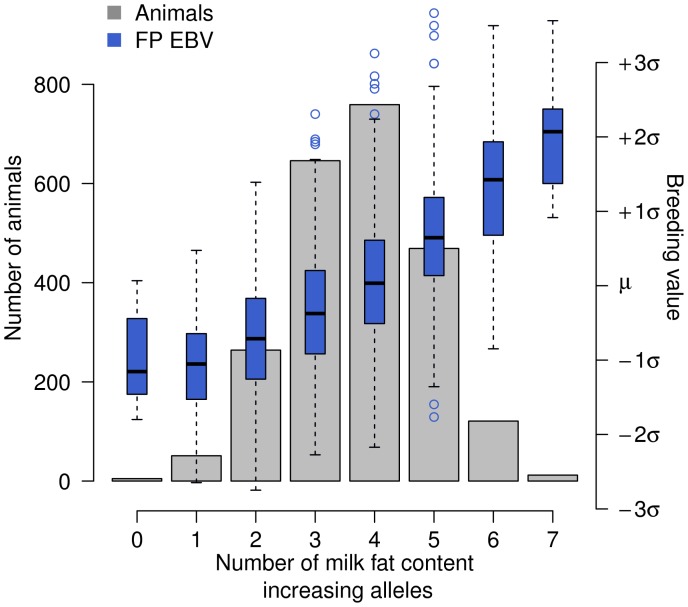
The combined impact of the four identified QTL on BTA5, 14, 20 and 27 on the estimated breeding value for milk fat percentage in the German Holstein-Friesian population.2327 Holstein-Friesian animals are grouped according to the number of alleles that increase the milk FP EBV. The grey bars indicate the number of animals with an increasing number of FP increasing alleles. The box plots represent the FP EBVs for each group. No animals carrying eight FP increasing alleles were observed in the study population.